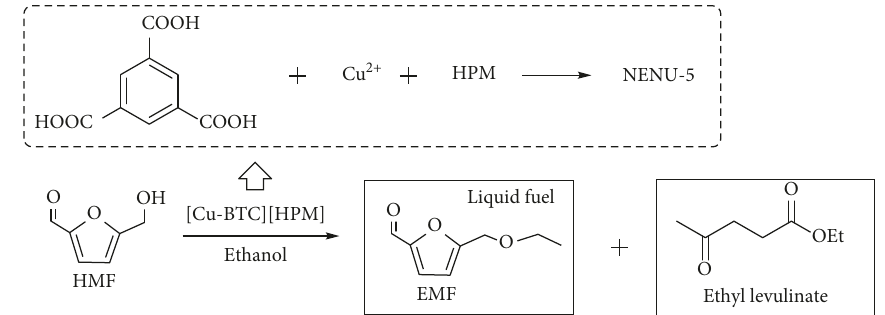
Figure 1: Schematic of the catalyst preparation and catalytic